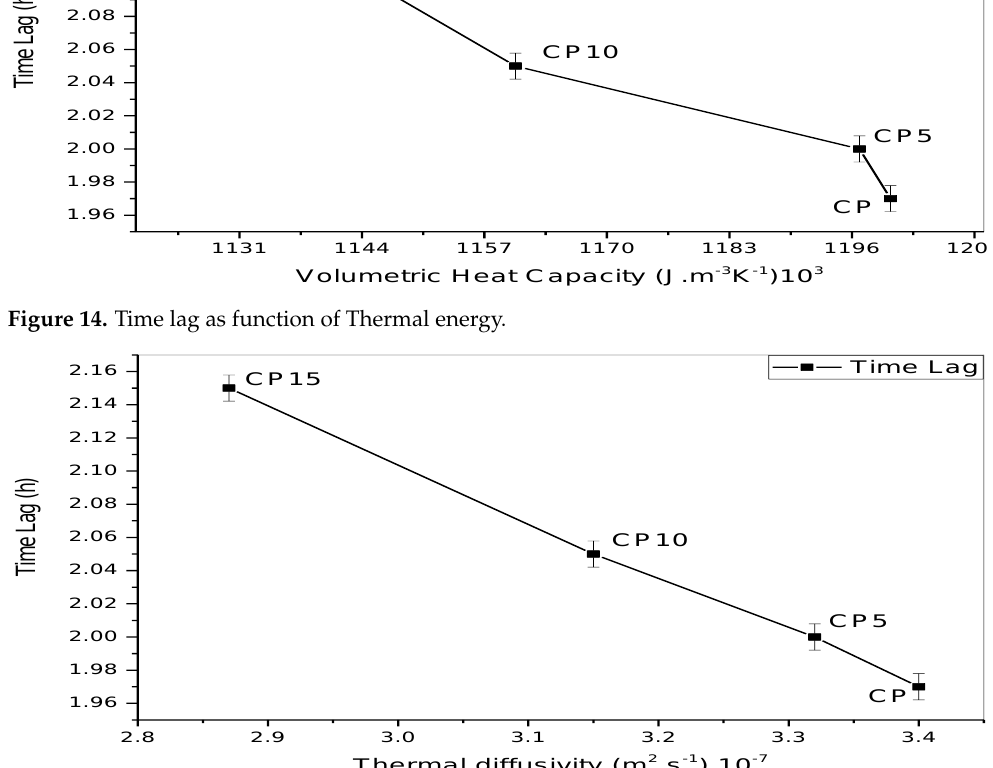
Figure 15. Time lag as function of thermal diffusivity. It was discovered in Table 2 that increasing the proportion of wheat straw in the plaster samples resulted in an increase in thermal resistance as well as an increase in the time lag of the plaster samples; whereby, with the incorporation of 15% of wheat straw, it led to an improvement of 9.14% compared to the